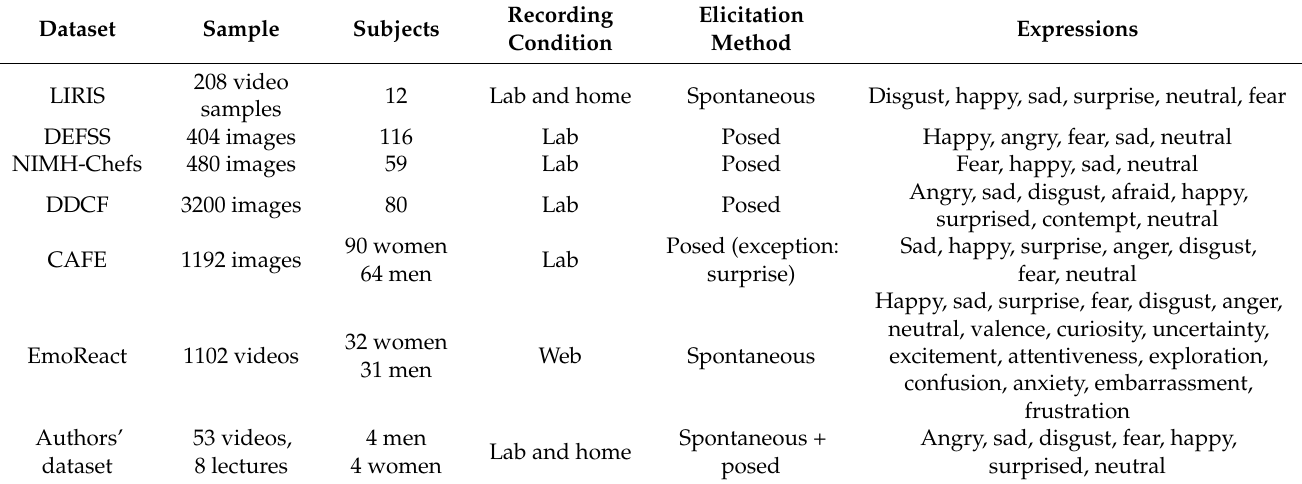
Table 2. Comparison of Kids’